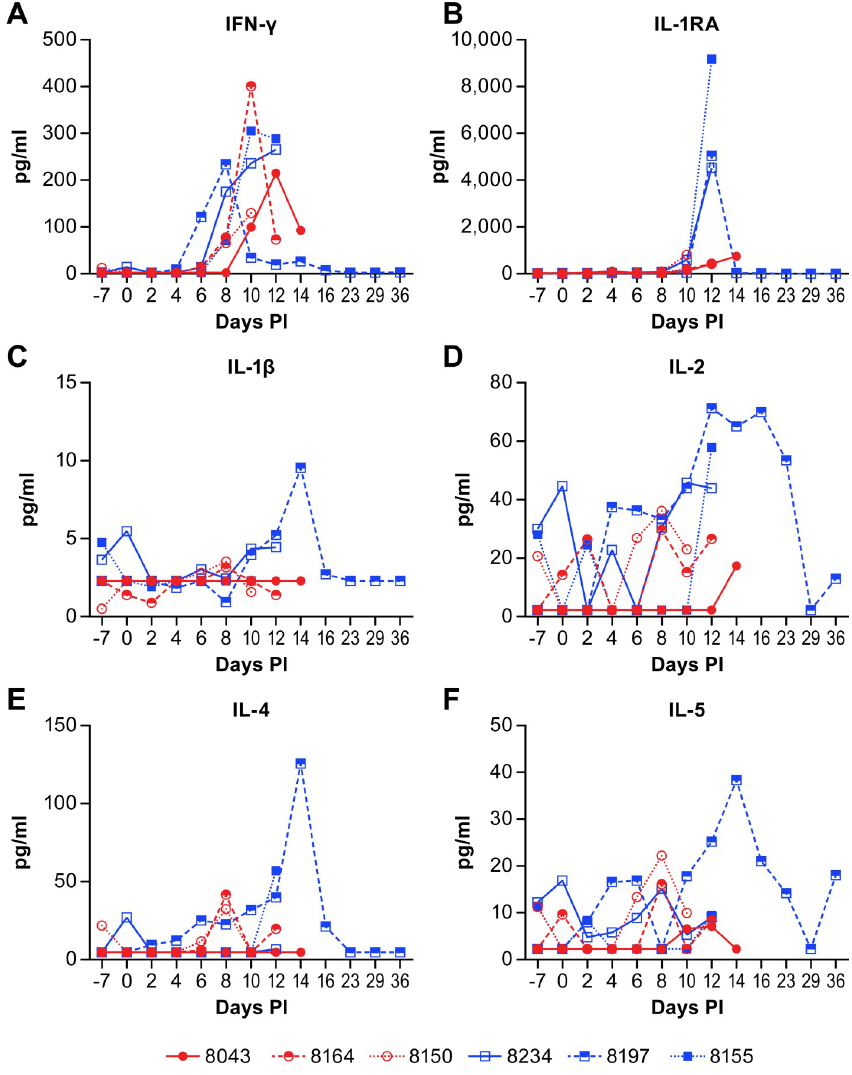
Fig 2. Plasma cytokine levels in animals infected with NiV. IFN γ (A), IL-1RA (B), IL-1 β (C), IL-2 (D), IL-4 (E) and IL-5 (F) levels in individual animals over the course of disease following NiV infection. Animals in the low dose group are displayed as red circles and those in the high dose group as blue squares. Values represent the mean of triplicate technical